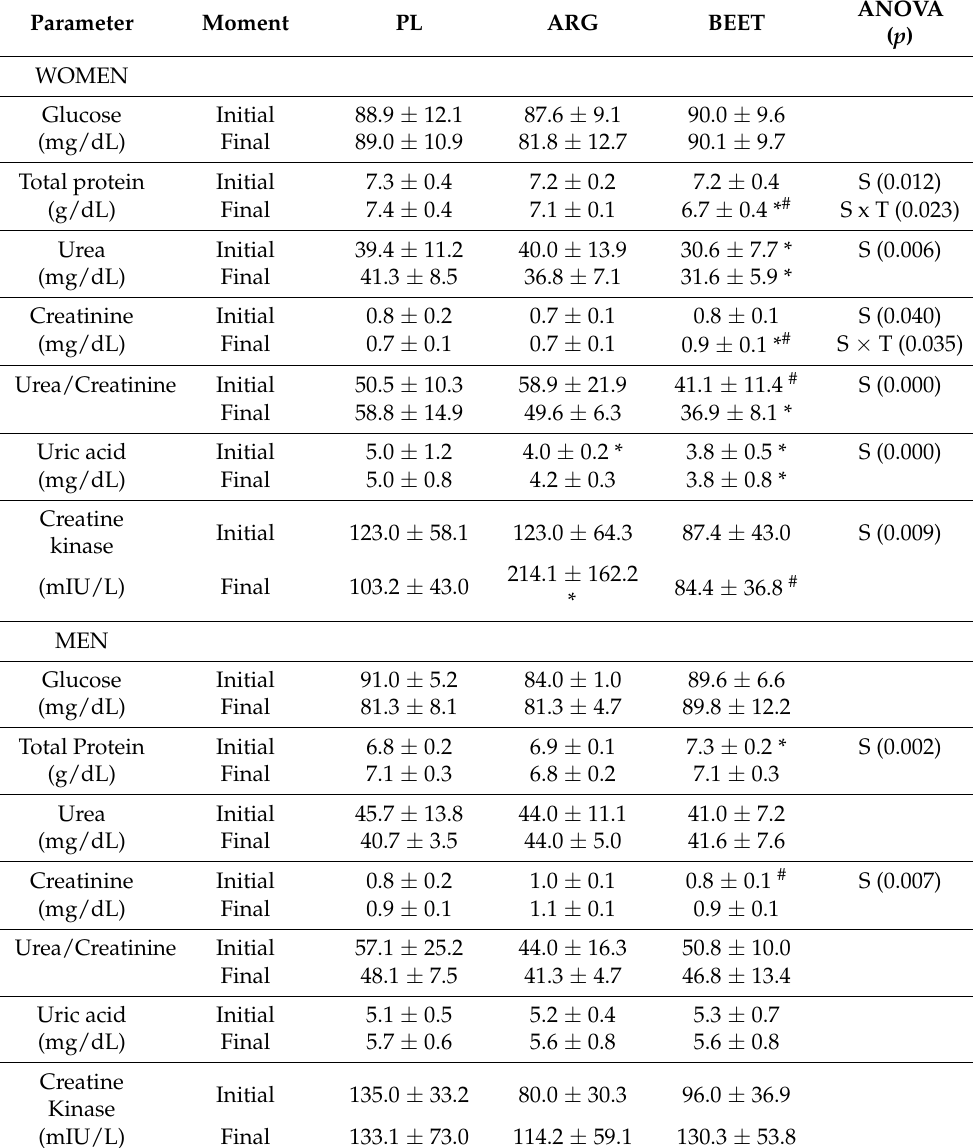
Table 4. Levels of circulating parameters in the placebo, arginine- and beetroot-supplemented groups in women and men participating in the study.